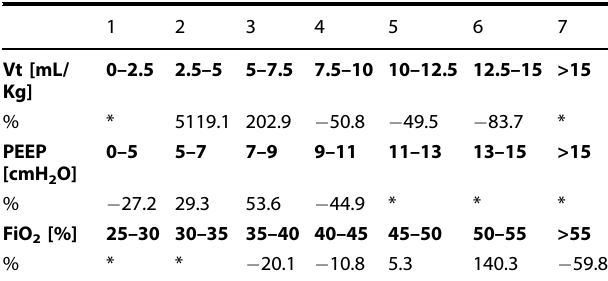
Table 3. Comparison of percentage of change for each action bin between VentAI policy and clinicians ’ policy (MIMIC-III